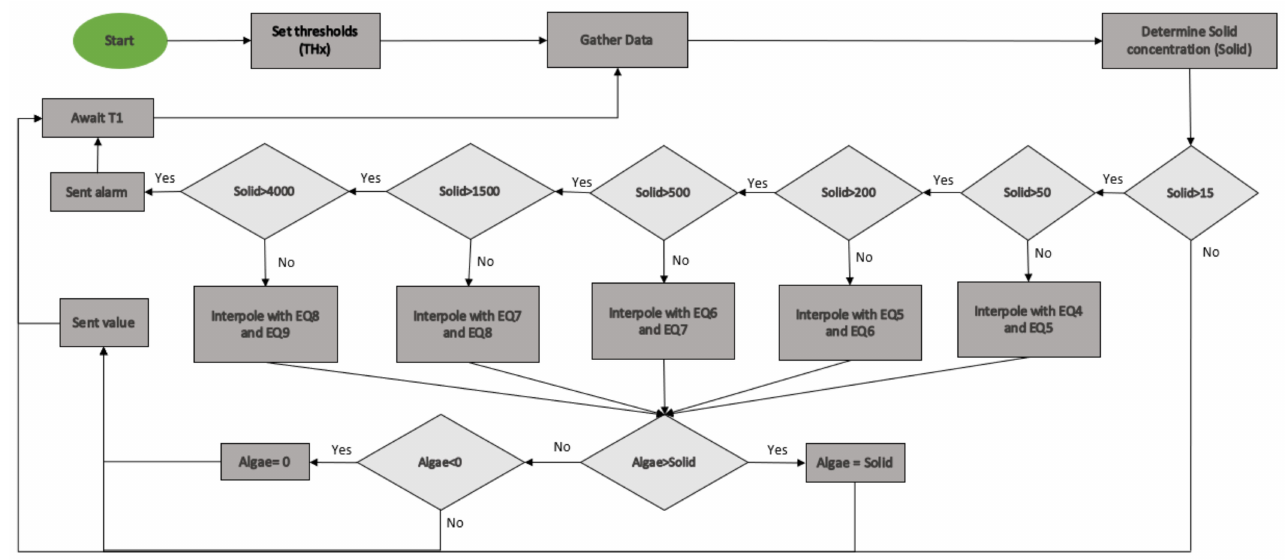
Figure 20. Prototype